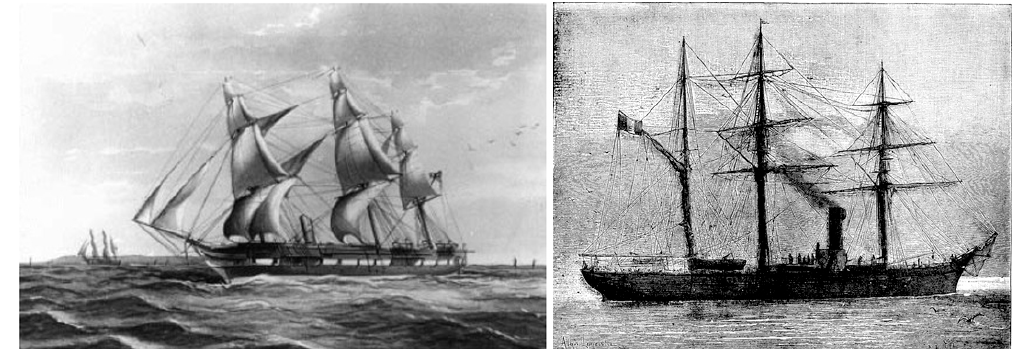
Figure 1. HMS Challenger (source: https://en.wikipedia.org/wiki/Challenger_expedition (last access: 19 March 2019) and the French scien- tific steamer, the Talisman (source: https://commons.wikimedia.org/wiki/File:THE-FRENCH-SCIENTIFIC-STEAMER-TALISMAN.png, last access: 19 March